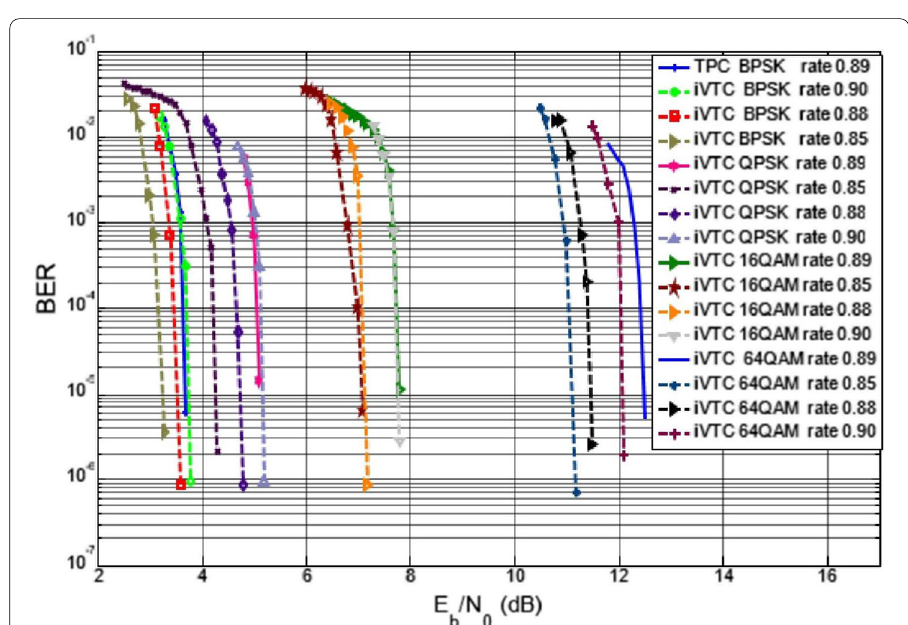
Fig. 5 (127, 120)TPC and equivalent iVTC BER versus E b / N 0 for BPSK, QPSK, 16QAM and